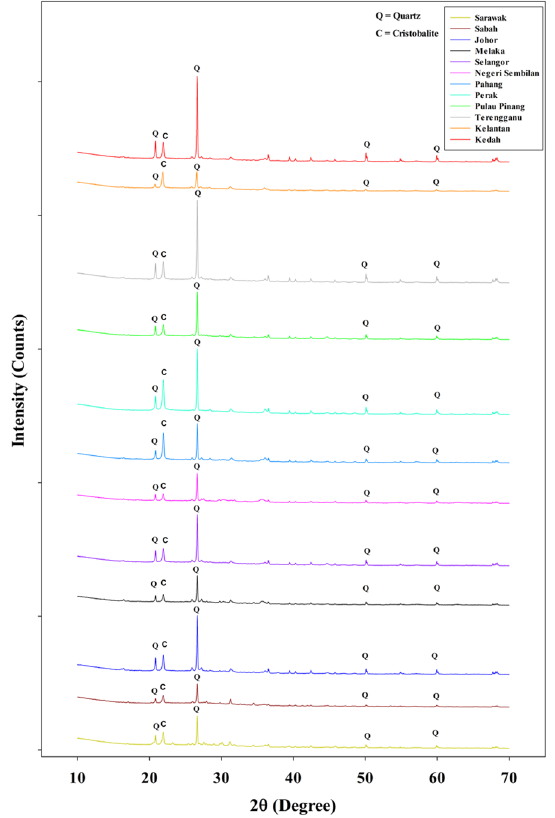
Figure 7. X-Ray diffraction results for all states.